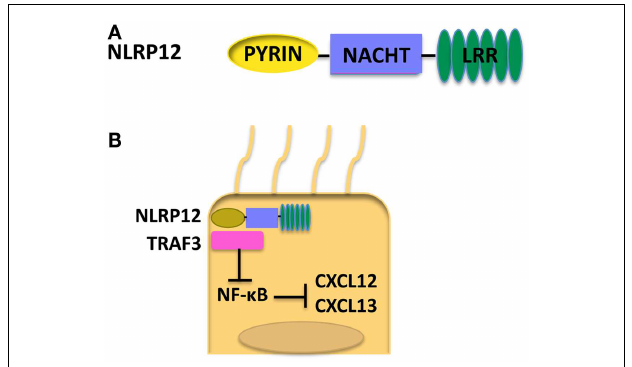
FIGURE 4 | (A) Structure of NLRP12. (B) When NLRP12 is present in intestinal epithelial cells it interacts withTRAF3 leading to stabilization of TRAF3 levels. Stabilization ofTRAF3 leads to regulation of the non-canonical NF- κ B pathway and diminished levels of the chemokines CXCL12 and CXCL13, both of which are upregulated in human cancers. Regulation of the non-canonical NF- κ B pathway by NLRP12 leads to decreased inflammation and tumorigenesis in the colon (17).